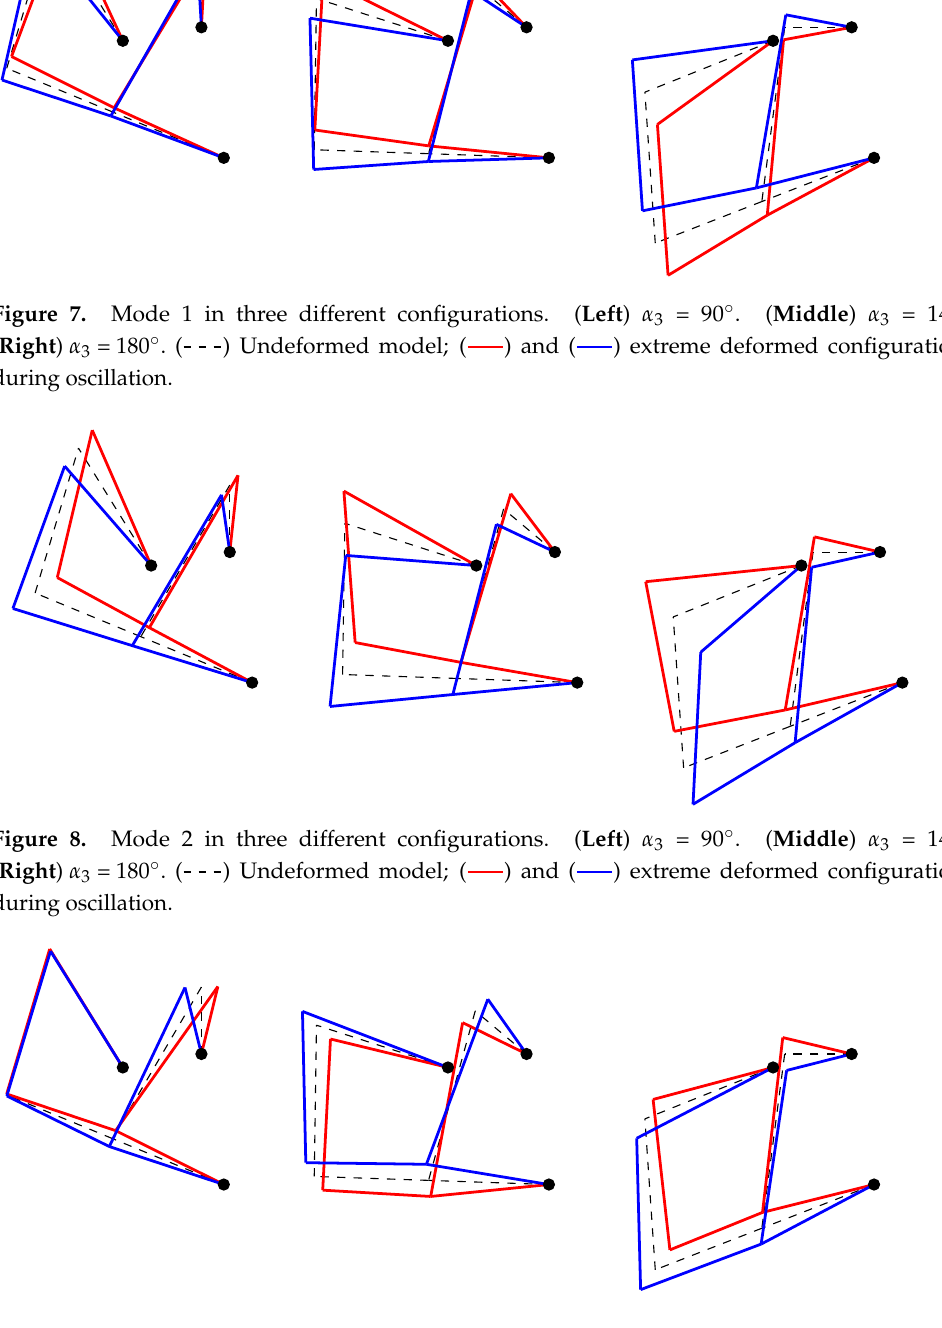
Figure 9. Mode 3 in three different configurations. ( Left ) α 3 = 90 ◦ . ( Middle ) α 3 = 140 ◦ . ( Right ) α 3 = 180 ◦ . ( ) Undeformed model; ( ) and ( ) extreme deformed configurations during